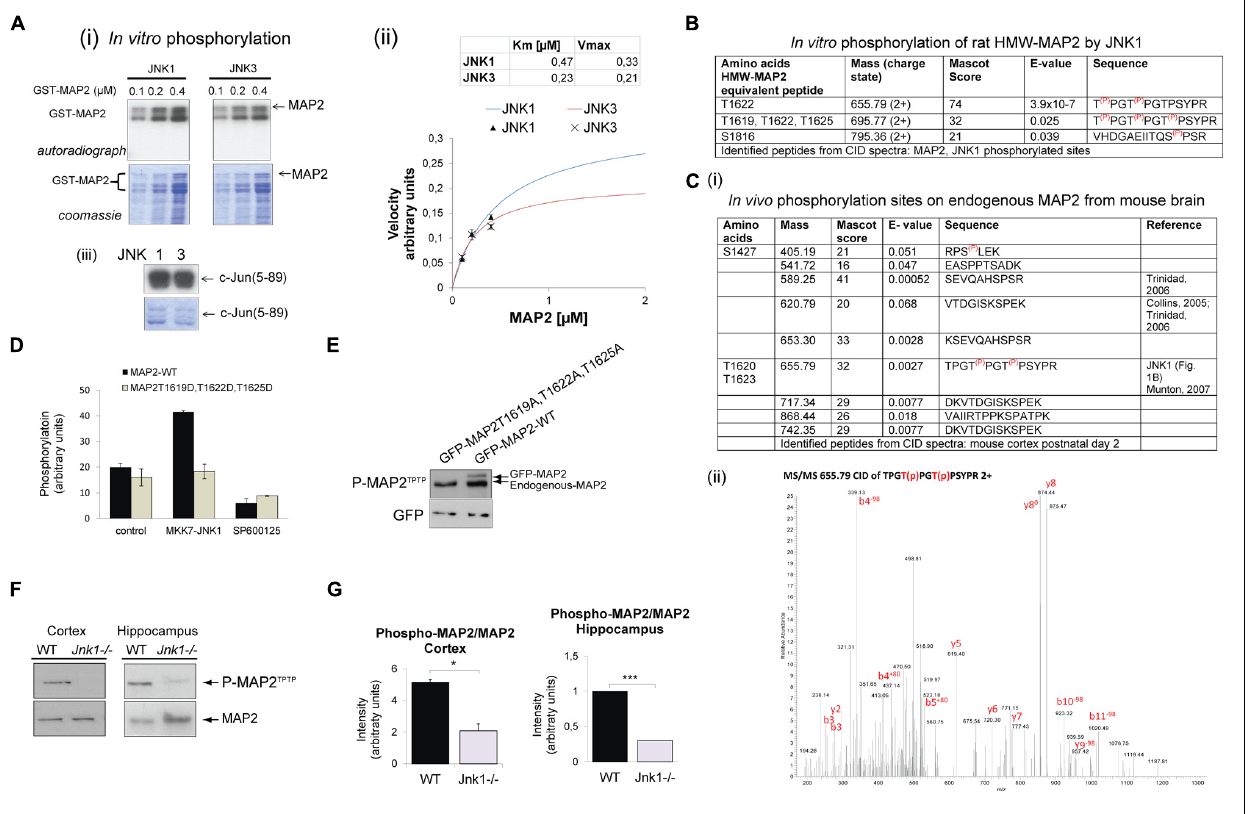
transfected with an active JNK chimera (MKK7-JNK1) together with GFP-MAP2 WT or GFP-MAP2 T1619D,T1622D,T1625D (as shown) and metabolically labeled with 32 P-ATP. GFP-MAP2 WT phosphorylation increased in cells expressing MKK7-JNK1, but phosphorylation of GFP-MAP2 T1619,T1620D,T1620D did not. Addition of the JNK inhibitor SP600125 (10 μ M) prevented the increase in GFP-MAP2 WT phosphorylation. Meaned data ± standard deviations are shown. (E) To validate the phospho-specificity of a phospho-MAP2 (P-MAP2 TPTP ) antibody generated against phosphorylated MAP2, GFP-MAP2 T1619A,T1622A,T1625A , or GFP-MAP2 WT were expressed in neurons and immunoblotted. The P-MAP2 TPTP antibody recognized endogenous MAP2 as well as ectopically expressed GFP-MAP2 WT , indicating that they are at least partly phosphorylated under basal conditions. The antibody did not detect GFP-MAP2 T1619A,T1622A,T1625A indicating specificity for the sites. (F) Tissue homogenates from cortex and hippocampi during the first postnatal week. Wild-type (WT) and Jnk1-/- mice were normalized for protein and immunoblotted for MAP2 or P-MAP2 TPTP . (G) Quantitative data from blotting of post-natal cortex and hippocampus. P-MAP2 TPTP levels were normalized to MAP2. Means ± SEMs are shown from three repeats. * p < 0.05; *** p <